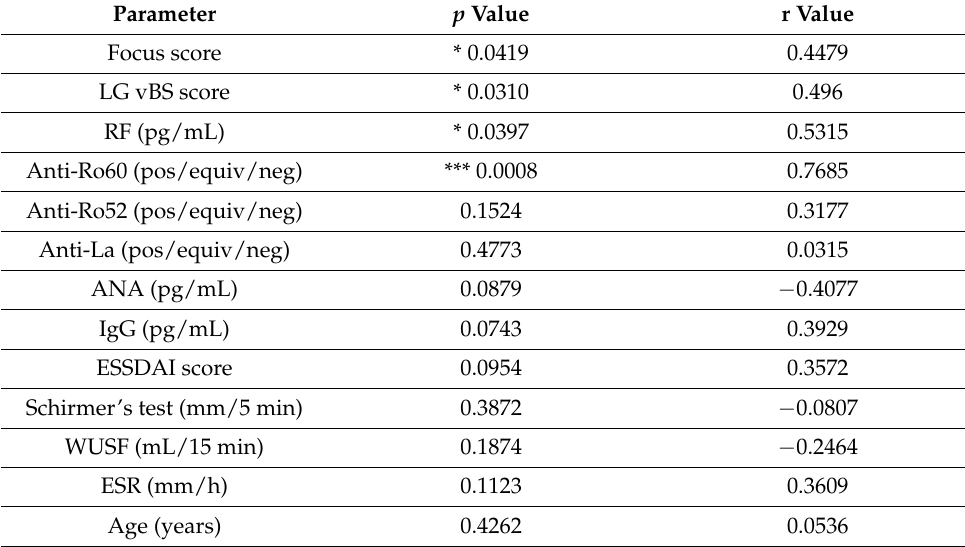
Table 2. Elevated sMer is correlated to some aspects of severe disease in SjS patients. The relationship between the sMer level and SjS diagnostic criteria was analyzed by Spearman’s rank correlation test where * p < 0.05, and *** p < 0.001. In addition, patient seropositivity for anti-Ro52, Ro60, and La was determined by the Inno-LIA assay. Parameter p Value r Value Focus score * 0.0419 0.4479 LG vBS score * 0.0310 0.496 RF (pg/mL) * 0.0397 0.5315 Anti-Ro60 (pos/equiv/neg) *** 0.0008 0.7685 Anti-Ro52 (pos/equiv/neg) 0.1524 0.3177 Anti-La (pos/equiv/neg) 0.4773 0.0315 ANA (pg/mL) 0.0879 IgG